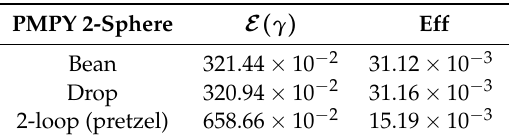
Table A2. Energy dissipation E ( γ ) and efficiency Eff of geodesic strokes of the PMPY 2-sphere swimmer, with X ( γ ) = 0.1, ε =